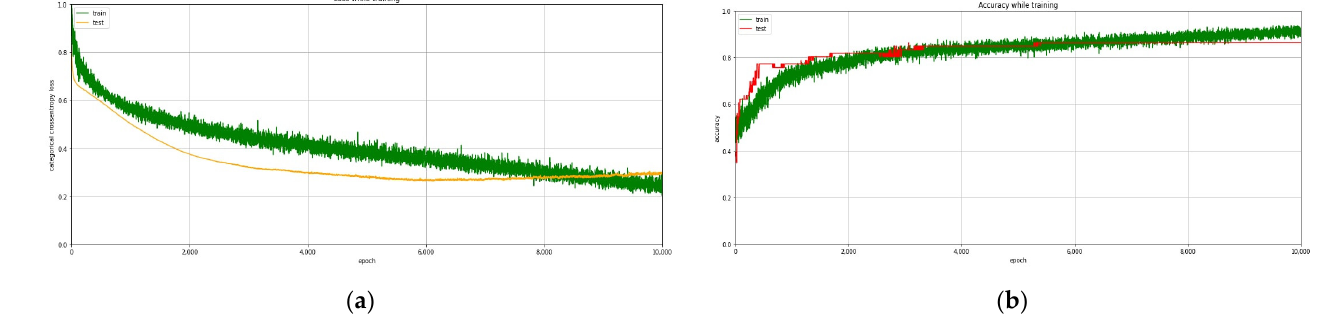
Figure 3. Training curves for BC: ( a ) Training process: loss; ( b ) Training process: accuracy.